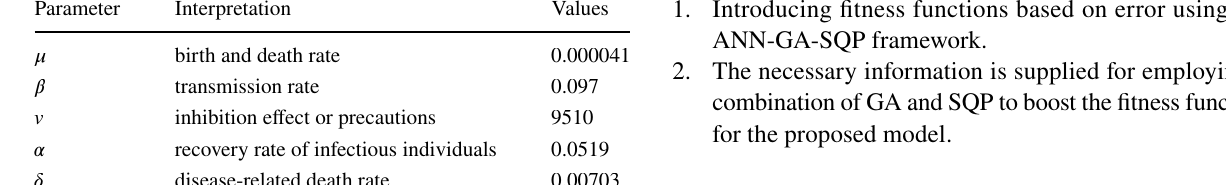
Table 2 Detail of involved parameters of SIR model